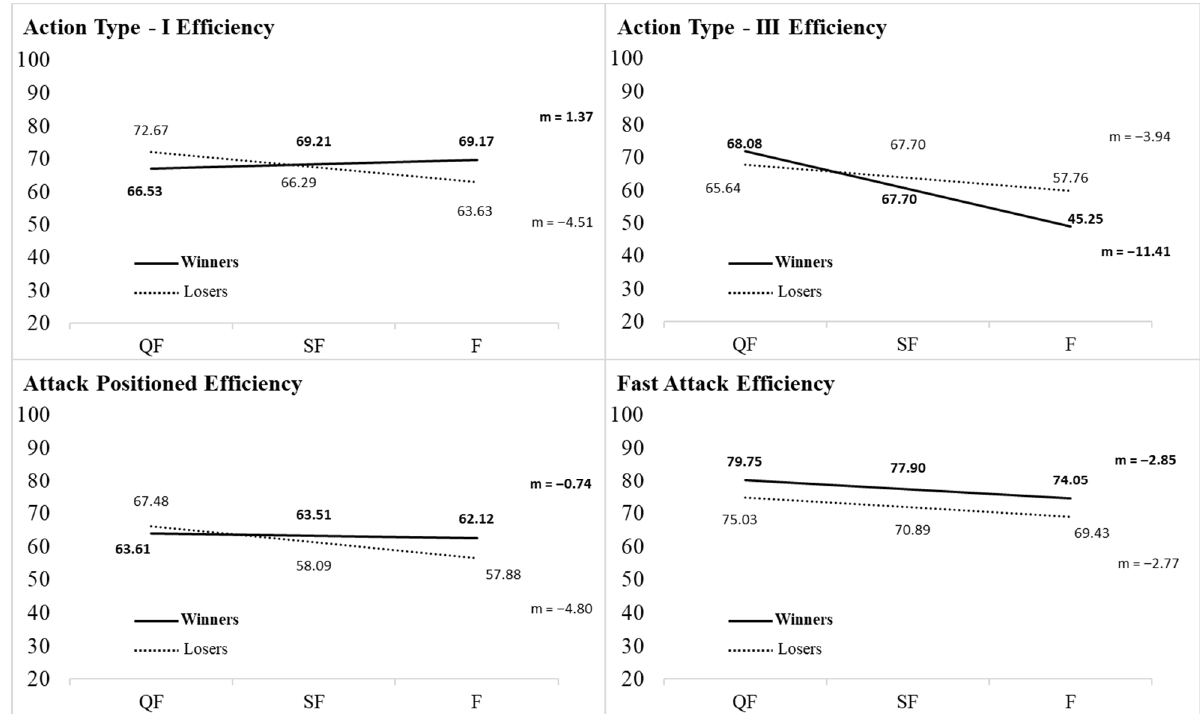
Appl. Sci. 2023 , 13 , 1366 Figure A2. Linear tendency lines of goals. Note : QF= Quarterfinals; SF= Semifinals; F= Finals. Figure A2. Linear tendency lines of goals. Note: QF = Quarterfinals; SF = Semifinals; F = Finals.